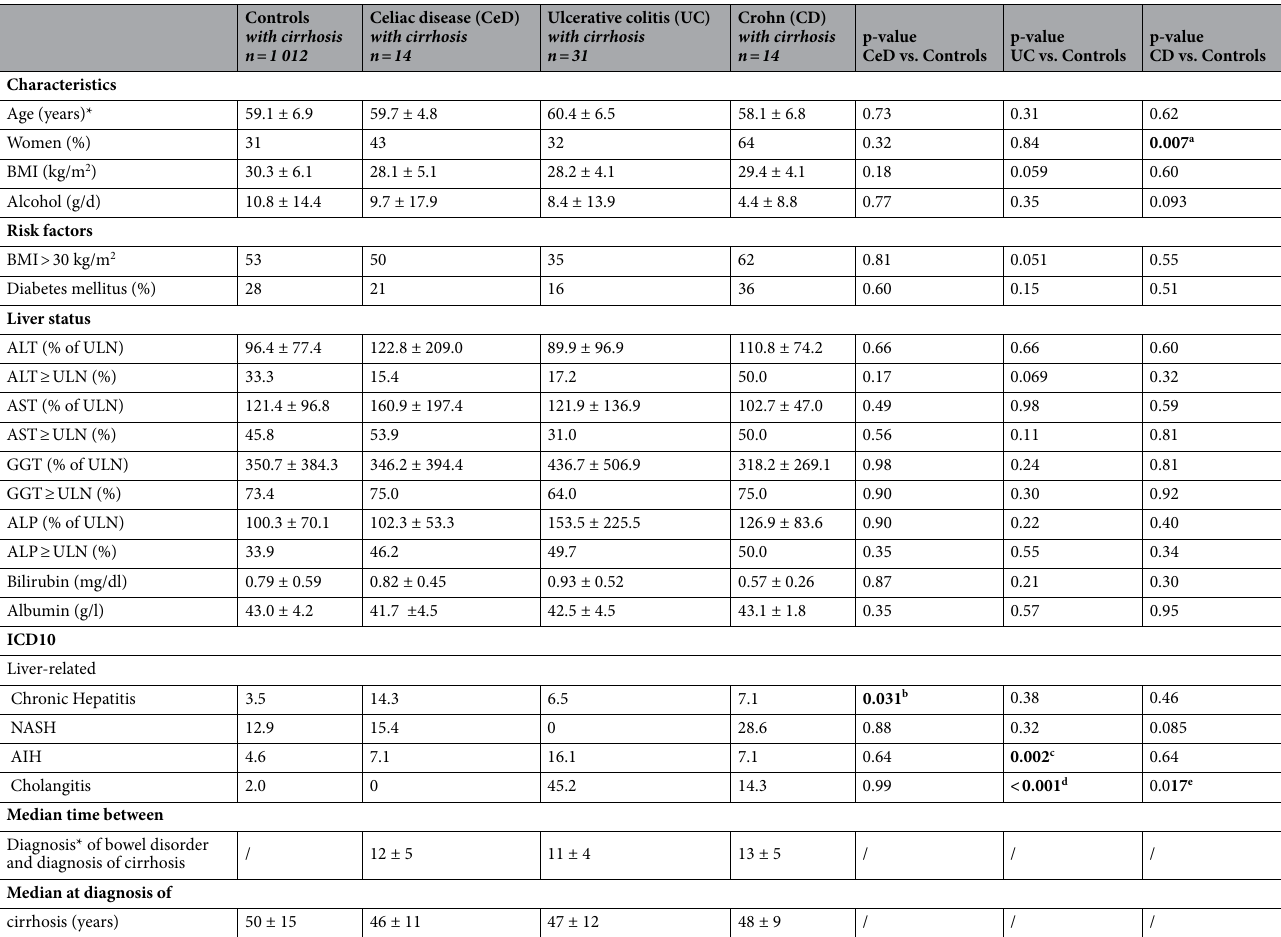
Table 4. Liver phenotype in cirrhotic UK Biobank cohorts with celiac disease, Crohn’s disease or ulcerative colitis compared to controls. Quantitative measures are expressed as median with IQR or relative